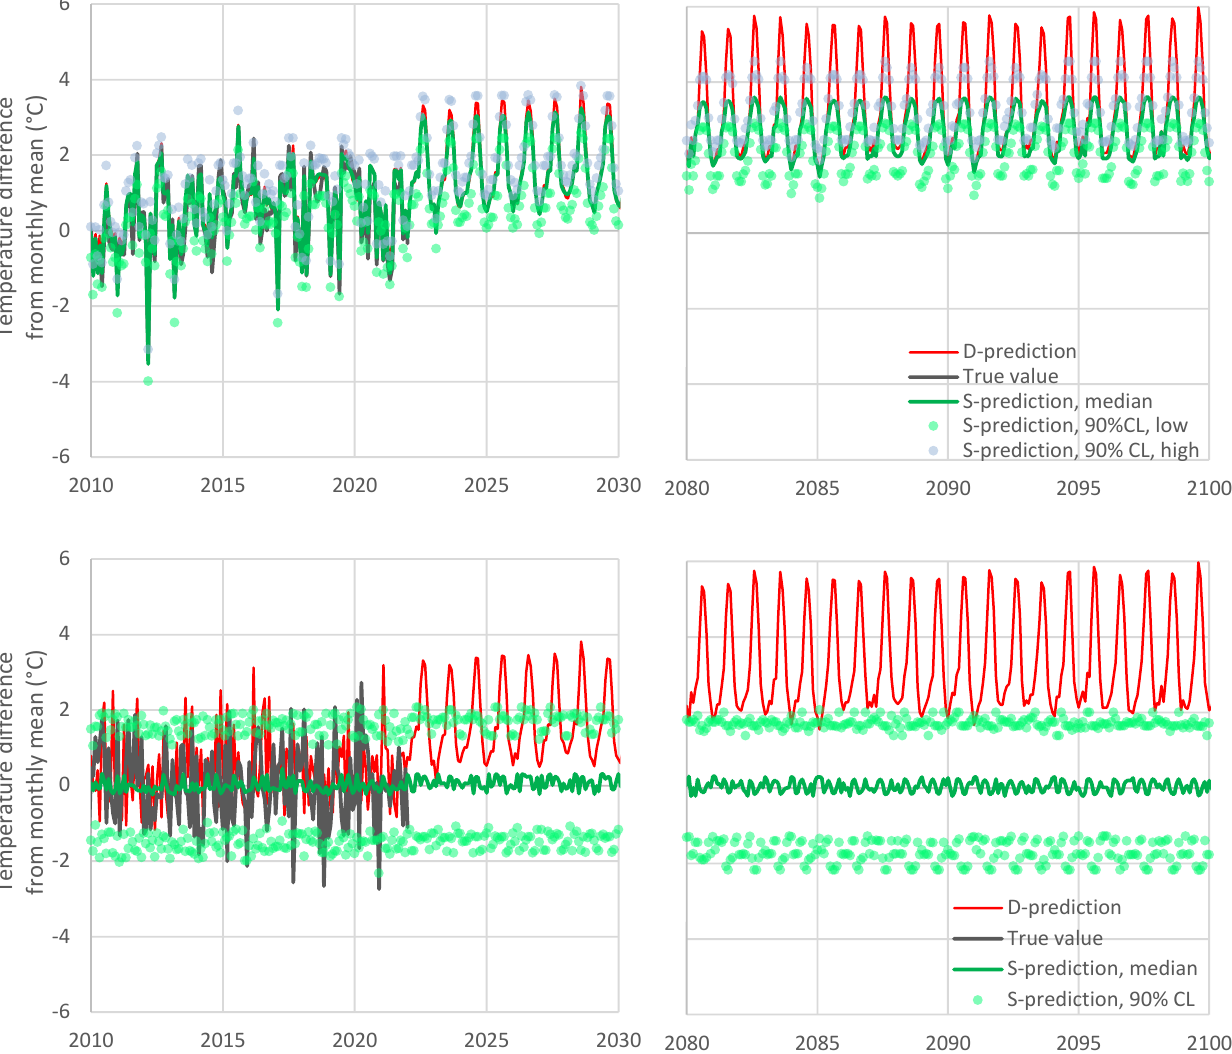
Figure 7. Modified Figure 5 for two hypothetical cases, in which the D-model values are reconstructed so as to be ( upper ) very close to reality, by replacing the D-model series with the weighted sum of true and D-model values with weights of 0.75 and 0.25, respectively, and ( lower ) completely irrelevant to reality, by randomly rearranging the time order the true values.